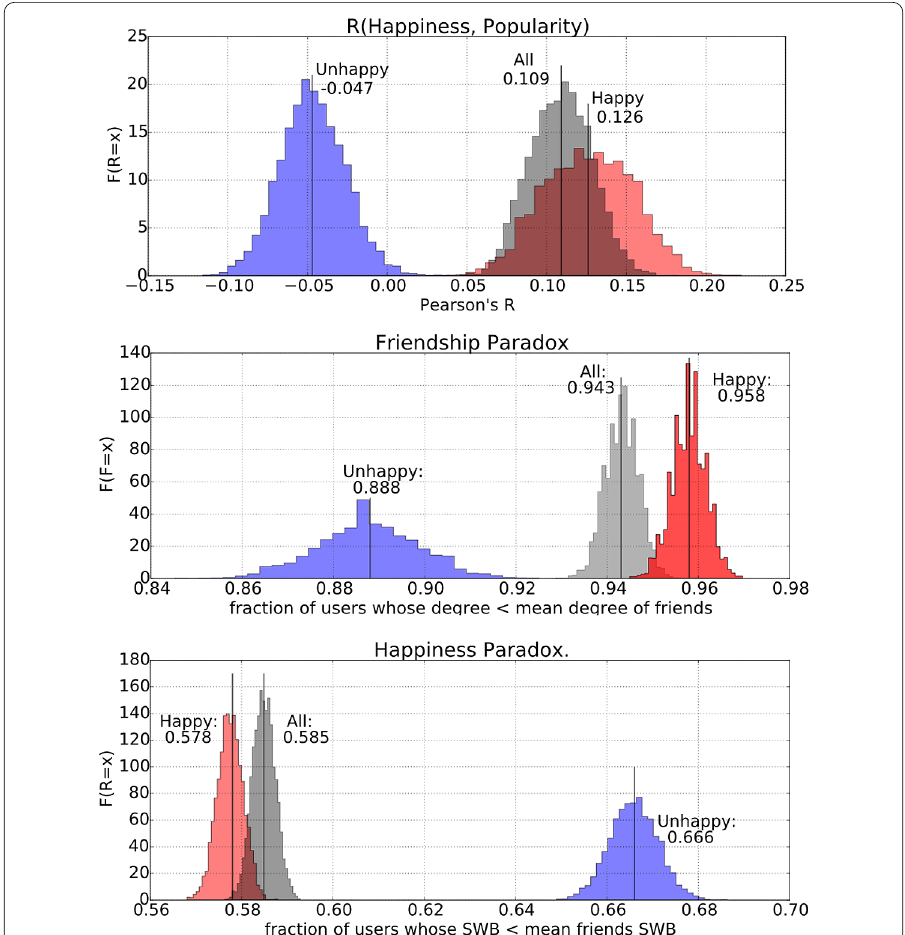
Figure 3 Bootstrapped estimates of the correlation between Happiness and Popularity, and the magnitude of the Friendship and Happiness Paradox for Happy and Unhappy subjects. Top : Estimated Pearson’s R correlation coefficients (95% Confidence Intervals in brackets) between individual Happiness (Subjective Well-Being) vs. individual Popularity (log degree) for All subjects: 0.109 [0.077,0.140], Happy group: 0.126 [0.081,0.171], and unhappy group: -0.047 [–0.08,–0.013]. Middle : Distribution of Friendship Paradox values for all subjects 0.943 [0.937,0.949], happy group: 0.958 [0.951,0.964], and unhappy group 0.888 [0.869,0.906]. Bottom : Distribution of Happiness Paradox values for all subjects: 0.585 [0.581,0.589], happy group: 0.578 [0.573,0.582], and unhappy group 0.666 [0.657,0.674].